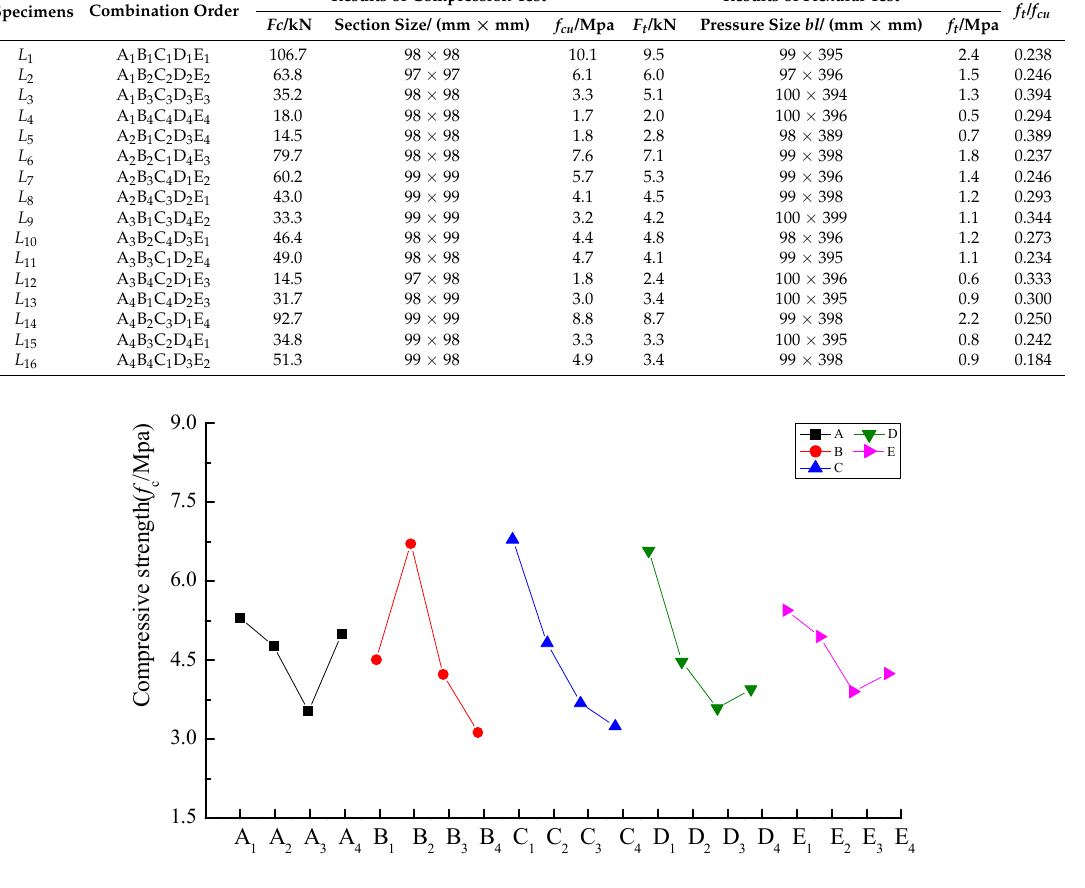
Figure 4. Intuitive analysis of the compressive strength.